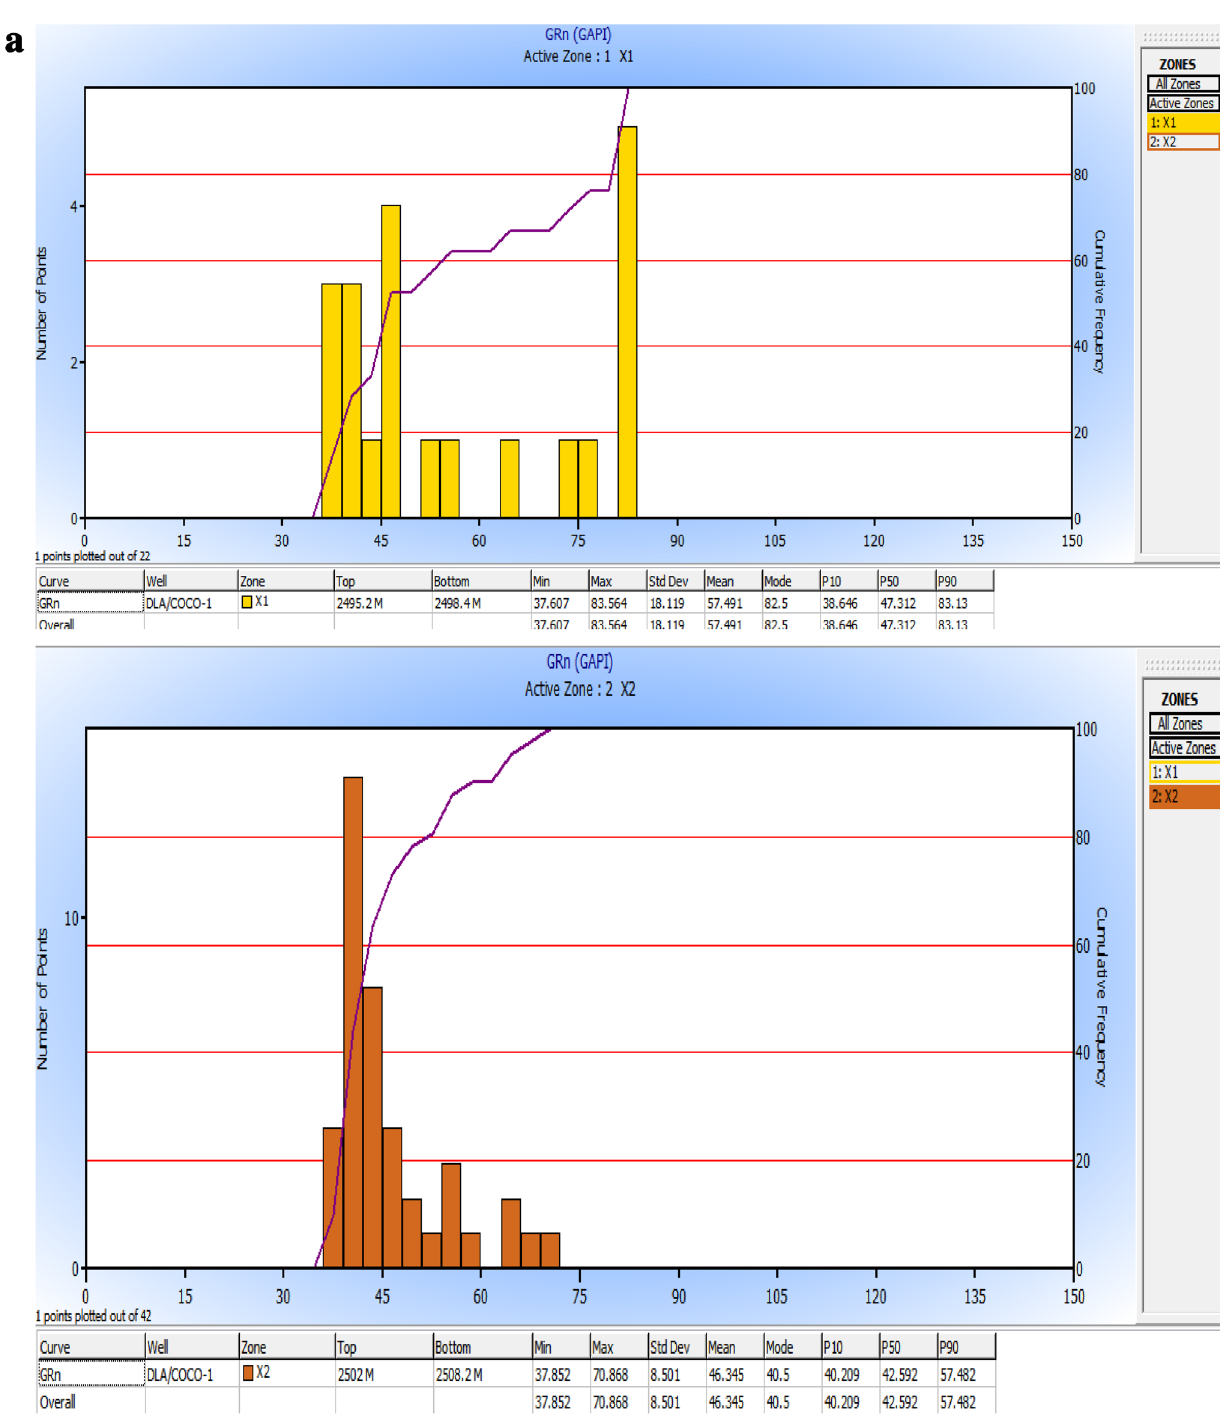
Fig. 5 a GR_Histogram for Well X reservoirs showing considerable points plotting beyond 60API in X 1 and most points clustering below 60 API in X 2 revealing that X 2 is clean relative to the dirty X 1 in terms